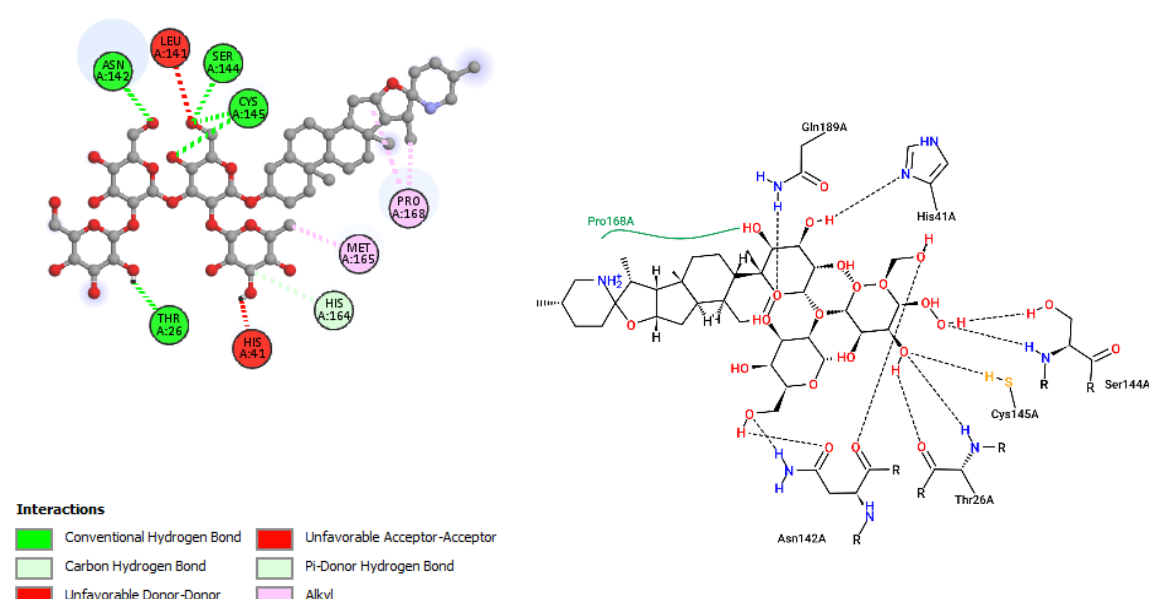
Figure 3 . Interaction of solaradixine with Mpro ( without N3 ).